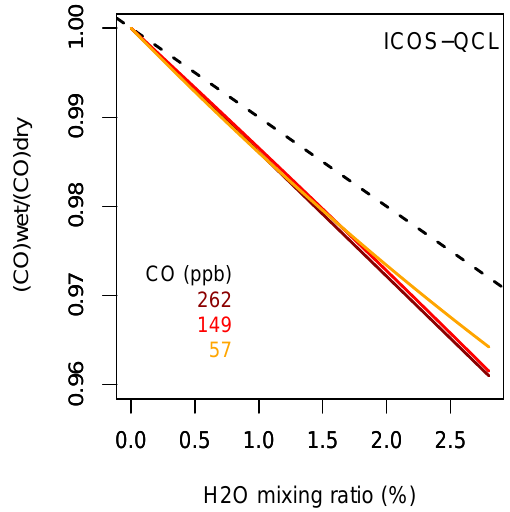
Fig. 10. Water vapour correction function for different CO mole fractions and operating pressures of the Mini-QCL instrument (coloured lines) and the effect of dilution (black dashed line).